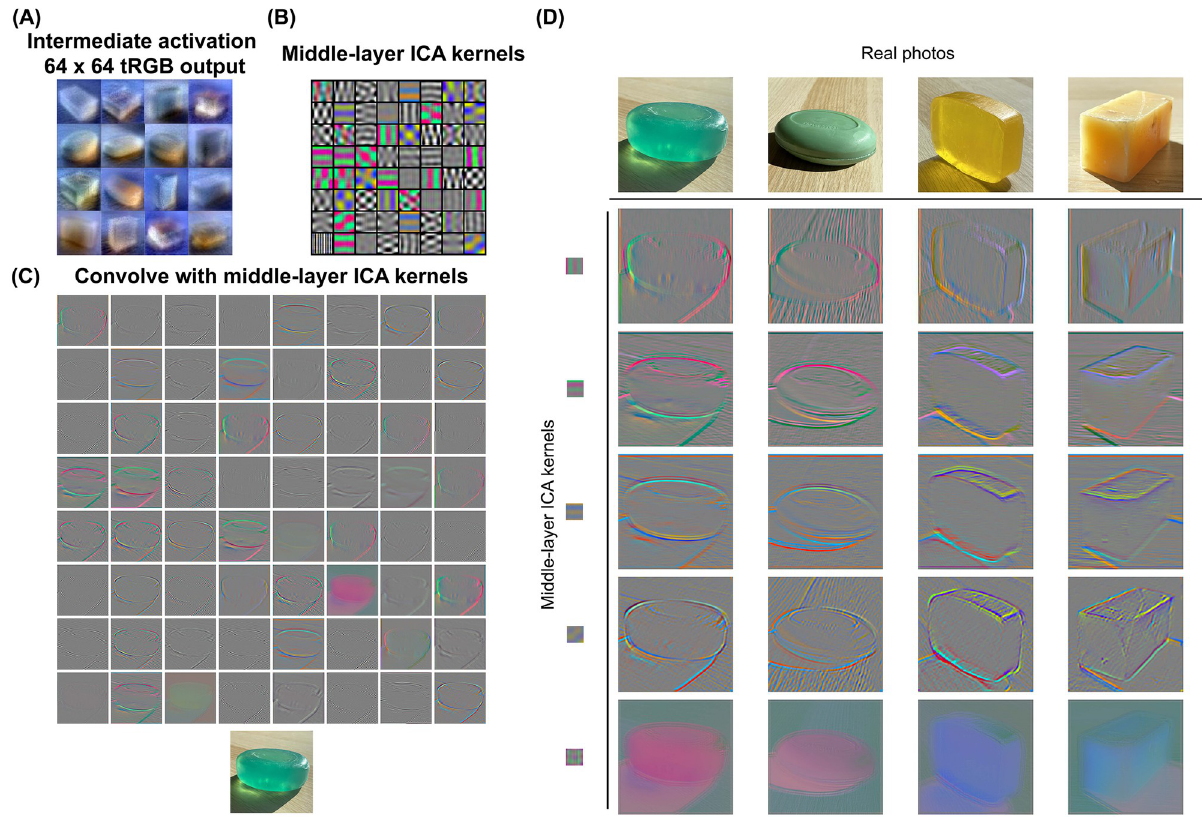
Fig 7. Visualization of features for translucency. (A) The intermediate generative results (tRGB layer output at 64 pixels × 64 pixels resolution) of the images from the high-translucency dataset. The images are resized for display. (B) Middle-layer ICA kernels obtained by training a system of 64 basis functions on 24 pixels × 24 pixels image patches extracted from images in (A). The kernels are of size 24 × 24. (C) Visualization of applying three- dimensional convolution of the individual ICA kernels in (B) on a real photograph of translucent soap. (D) The resulting filtered images of four different soaps with selected chromatic kernels. The mid-to-low spatial frequency chromatic kernels can capture features of translucency such as “chromatic caustics” (row 2, column 1), “glowing edges” (row 1, column 4), and “inner glow” (row 1, column 1 and 4). The orientation-free kernel in the last row reveals the variation of color over a relatively coarse spatial scale, which is also diagnostic of translucency.